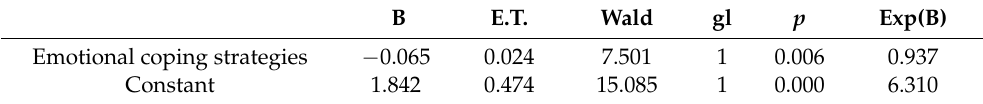
Table 4. Variables included in the proposed model. HIV subjects.